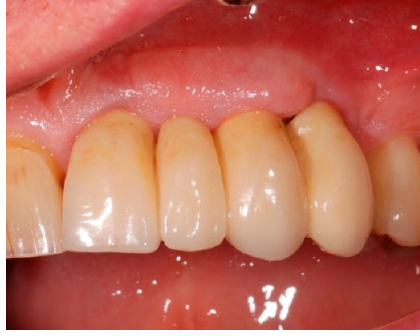
Figure 8. Clinical aspect at three-month follow-up (T1).